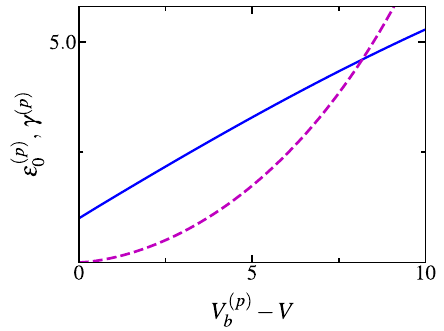
( p ) (solid line) and the width γ ( p ) 0